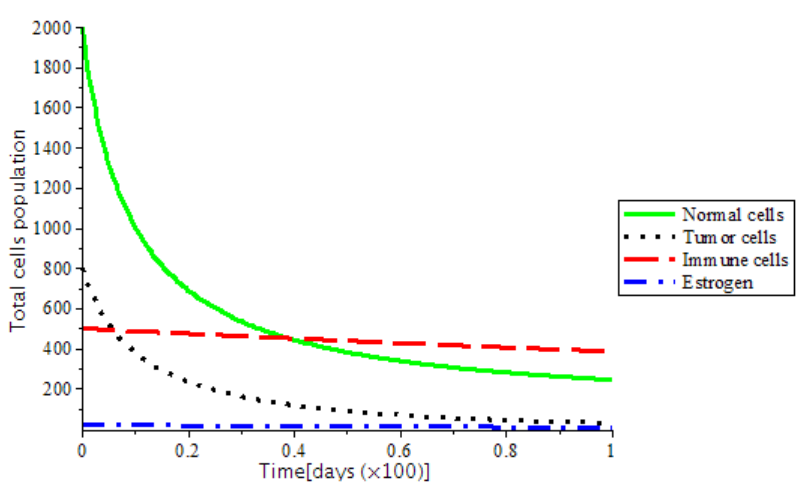
Figure 7. The variation of Total cells population depicted as locally asymptotically unstable.